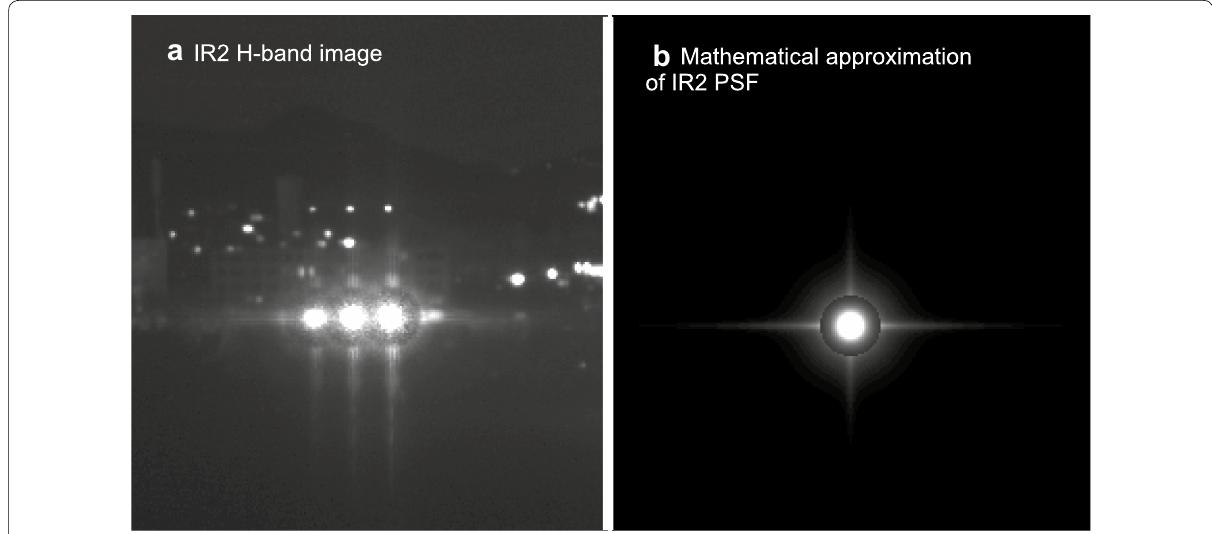
Fig. 7 Point‑spread function (PSF) of IR2. a Pre‑launch H‑band image, taken in the evening through the window of the laboratory, exhibiting hala‑ tion rings around the bright city lights (three in row). b Mathematical approximation of the IR2 PSF as described in the text. This is intended to be similar to the pattern seen in the real